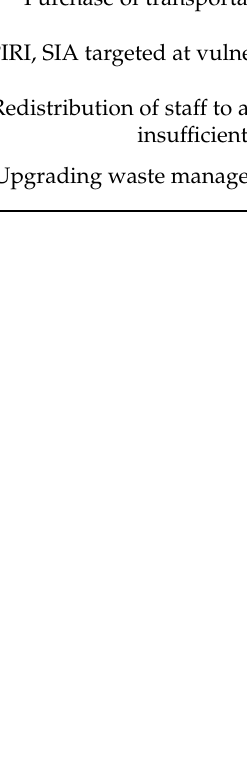
Figure A1. Complete correlation matrix (including all intervention